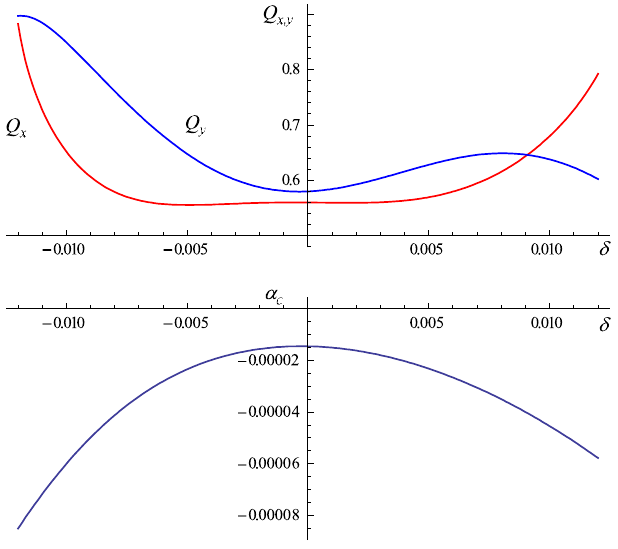
FIG. 2. Fractional betatron tunes (top) and momentum com- paction factor (bottom) vs momentum.